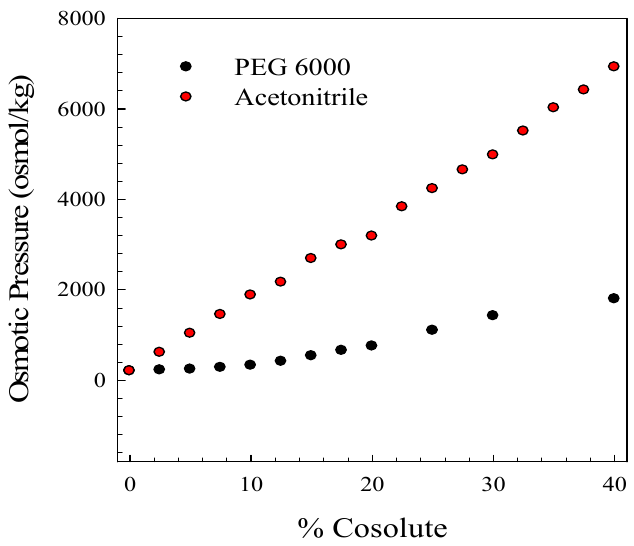
Figure 5. A comparison of the percent cosolute to osmotic pressure for